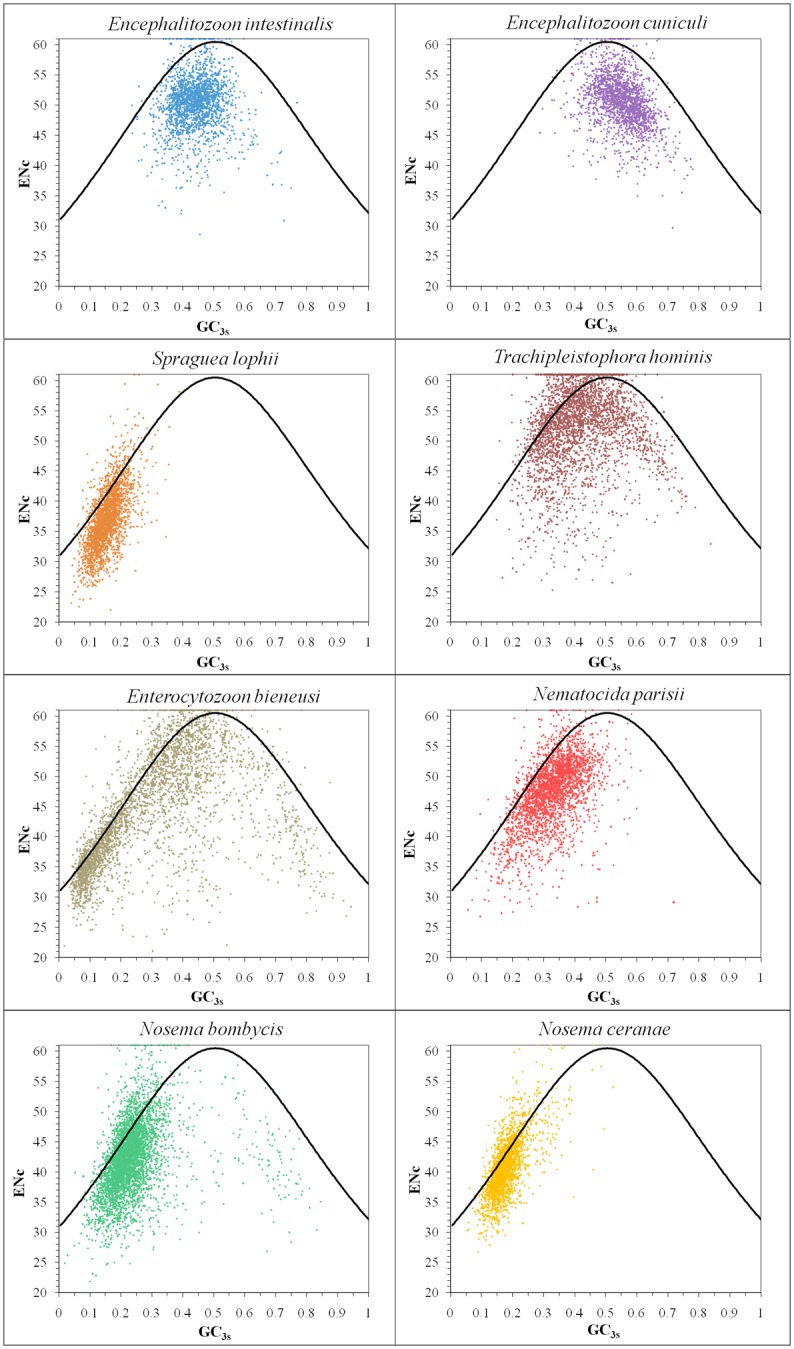
The ENc vs. GC3s plots of microsporidian genomes.The standard curve ENc = 2+GC3s+29/[GC3s
2+(1-GC3s)2] represents the expected ENc to GC3s. Most microsporidian genes are far away from the curve, showing that their codon usage pattern might be affected by other factors besides nucleotide composition. Some genes with the ENc score of 61 display no bias and use all the 61 sense codons.